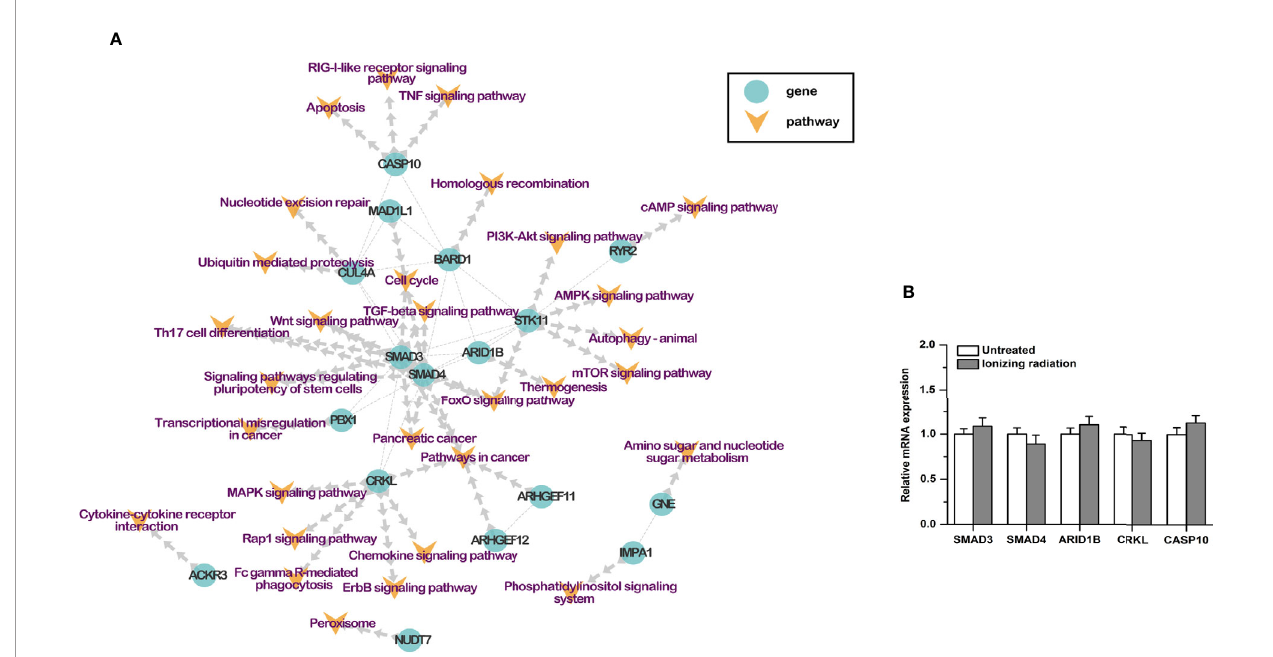
FIGURE 3 | (A) Protein-protein interaction network of RI-related genes. (B) The mRNA expression of SMAD3, SMAD4, ARID1B, CRKL, and CASP10 was not affected by ionizing radiation (4Gy) in PDAC